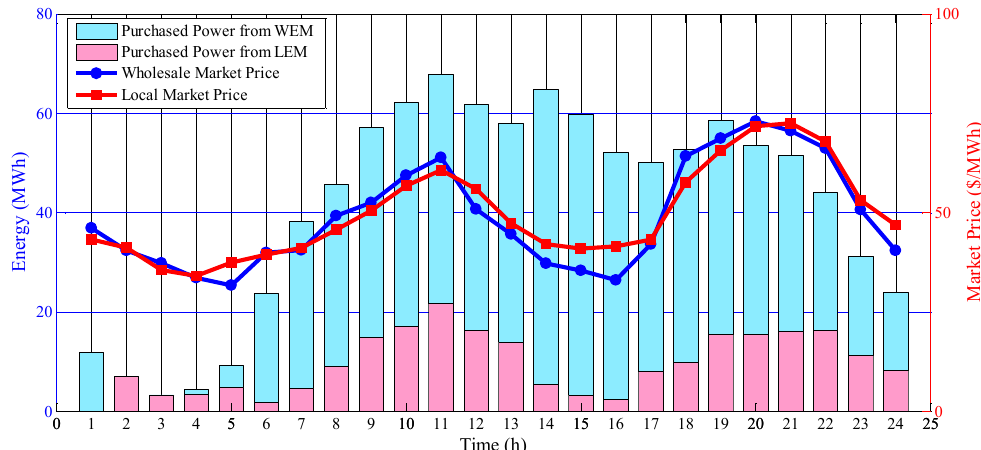
Figure 18. DSO’s exchanged energy with markets in the DA stage without considering the competitive environment.